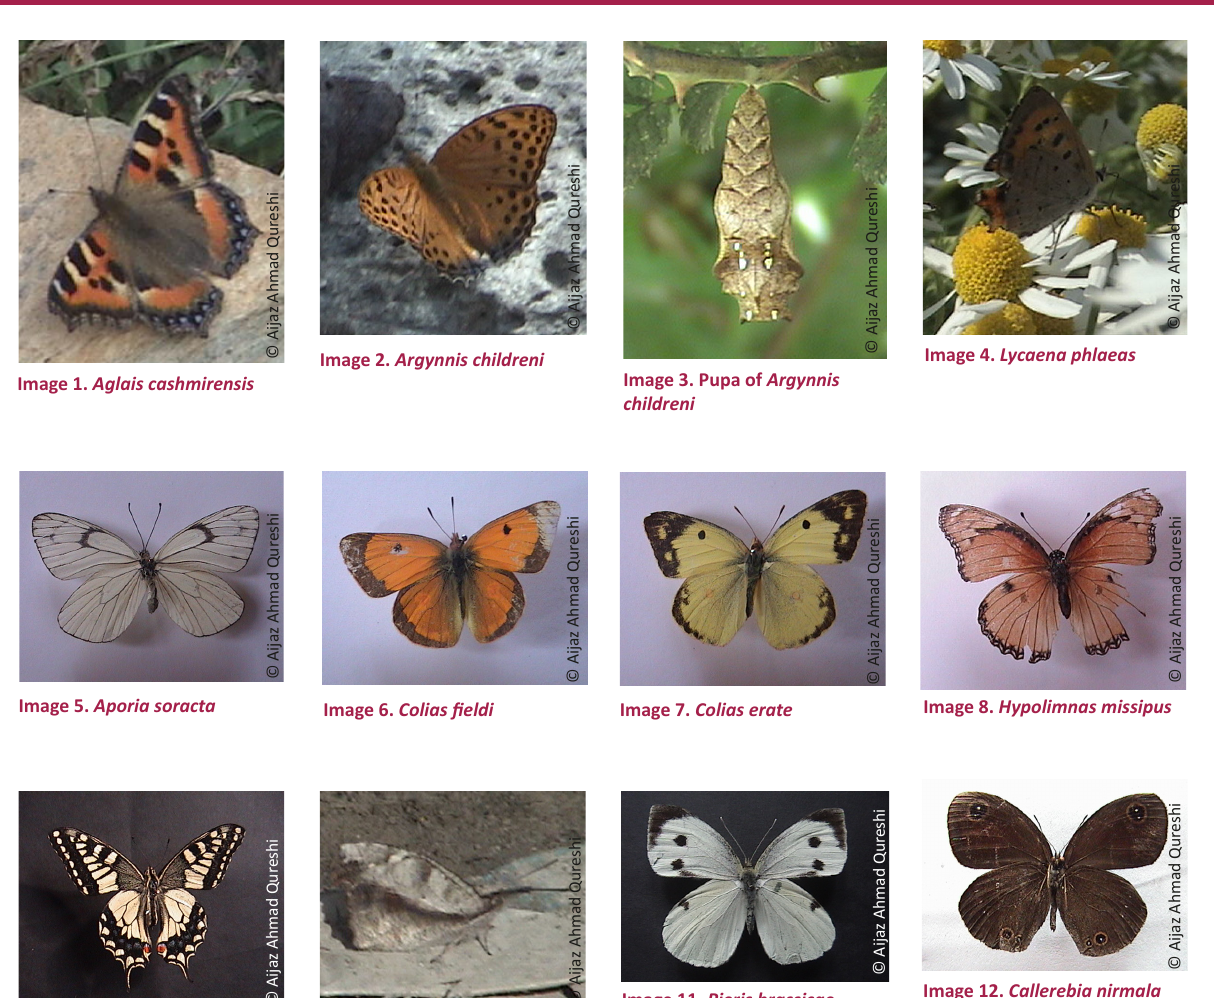
Image 12. Callerebia nirmala Image 11. Pieris